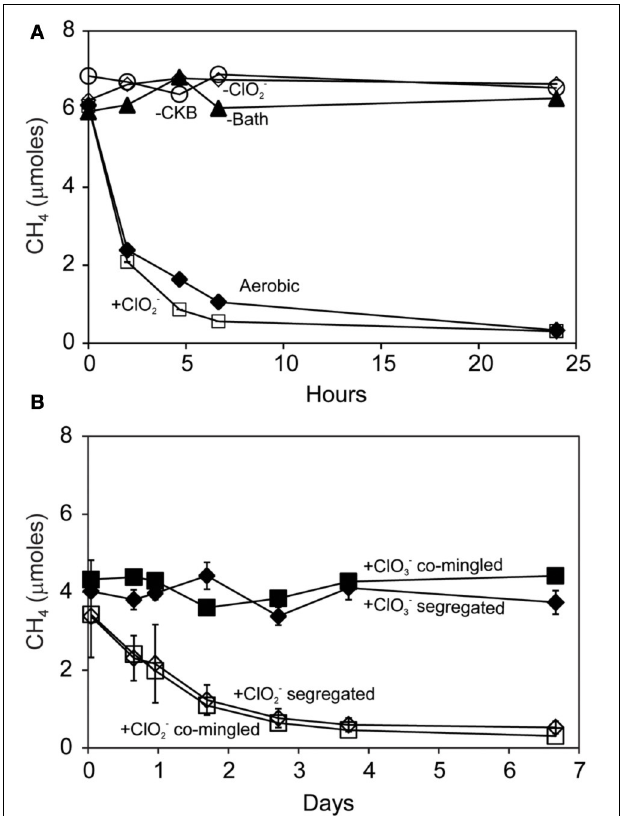
FIGURE 4 | Methane uptake by mixed cultures of D. agitata CKB with M. capsulatus Bath (A) and M. album BG8 (B) during anaerobic incubations. Cultures in (A) were co-mingled and provided with 5mM ClO − 2 (open squares). Aerobic controls are also shown (solid diamonds). Negative controls were prepared by withholding M. capsulatus Bath (solid triangles), D. agitata CKB (open circles), or ClO 2 − (open diamonds). Cultures in (B) were either co-mingled (squares) or segregated under a common headspace (diamonds) and provided with either ClO − 2 (open symbols) or ClO − 3 (solid symbols). Symbols represent the mean and standard deviation of triplicate measurements. Absence of bars indicates that the error is smaller than the symbol